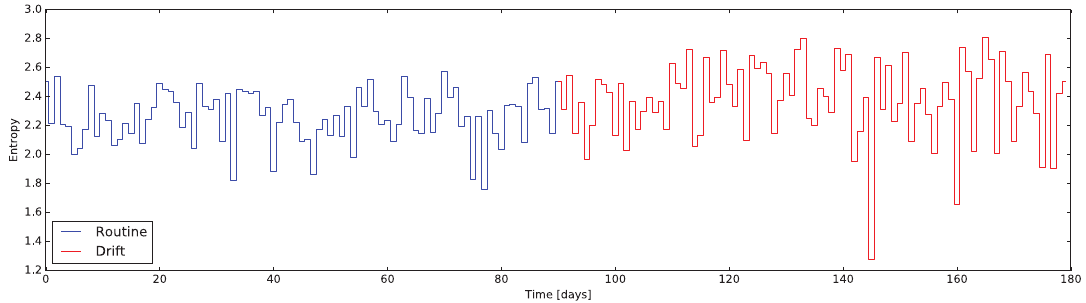
Figure 6. Whole house Entropy Based (EB) indicator: even if the drift barely noticeable, a set of sudden spikes in entropy are present after day 50. It is reasonable that the impact on the overall house EB indicator is limited since the person is still living his/her life without extreme